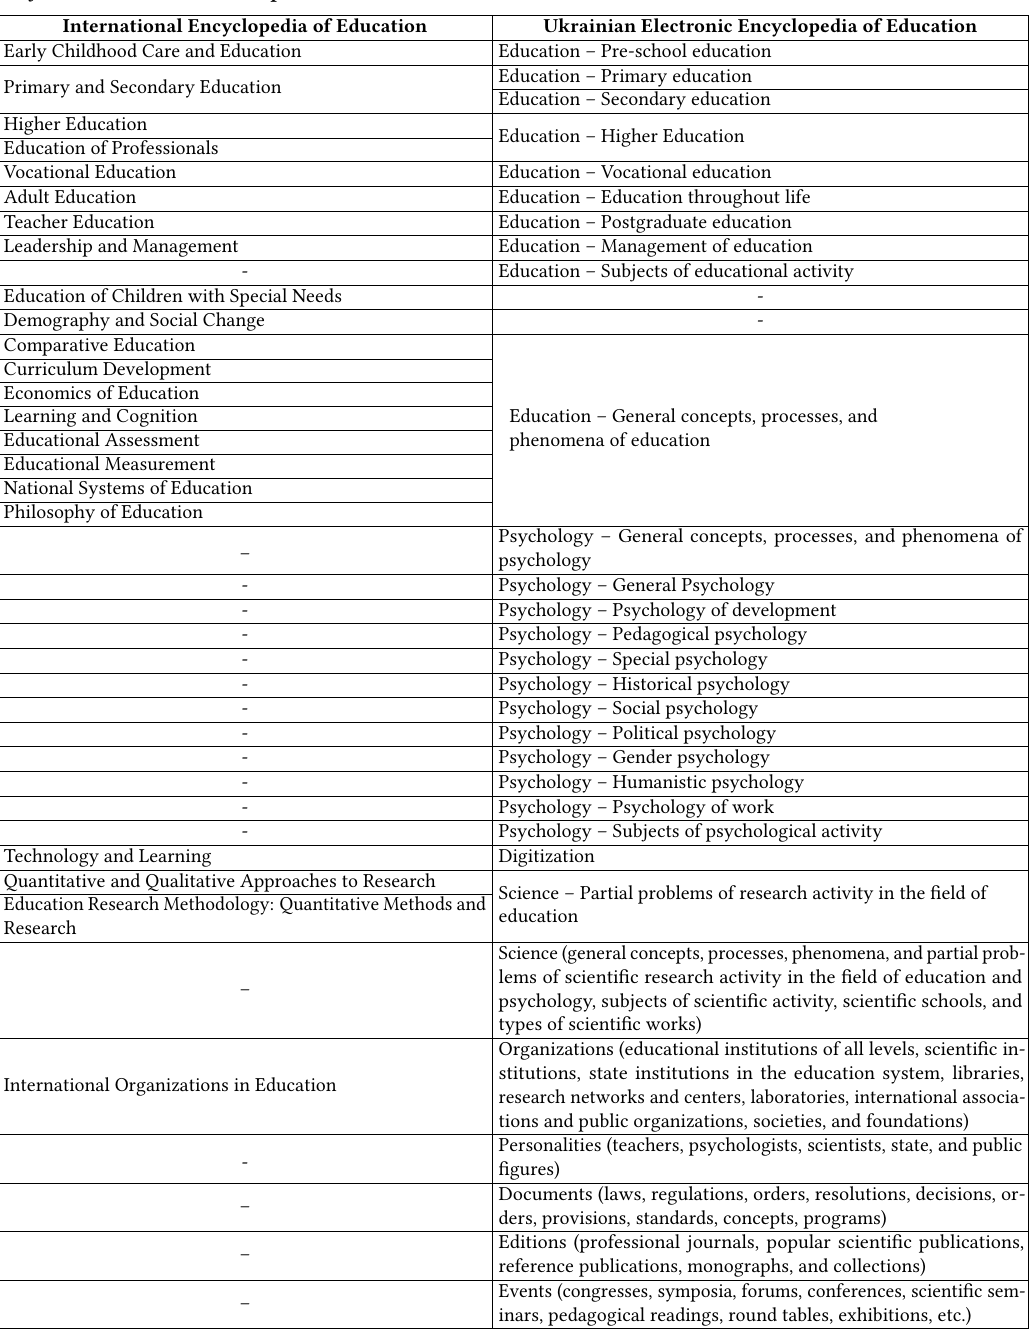
Table 1 Subject Classification.